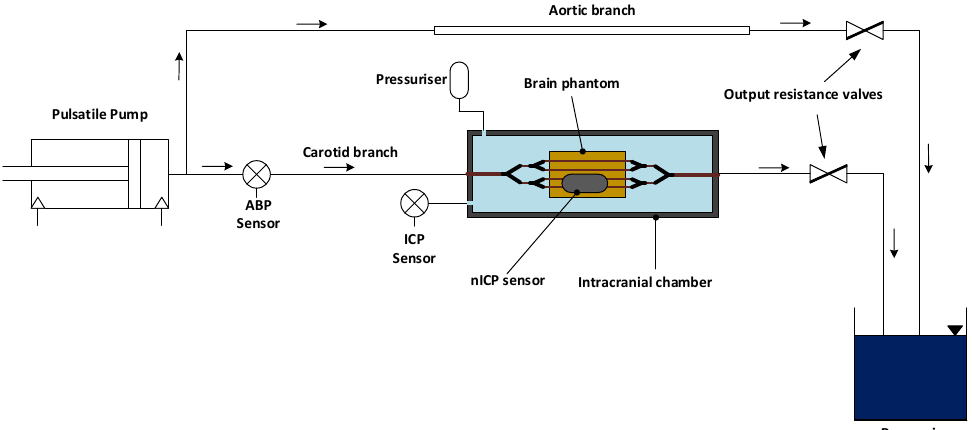
Figure 1. Schematic diagram of the in vitro model. A pulsatile pump on the far left recreates the pumping action of the heart and directs the blood flow into the rest of the system. The cardiovascular system comprises an aortic branch and a carotid branch leading to the intracranial chamber. The latter is composed by a rigid body in which the vascularised brain phantom is enclosed. The intracranial chamber also includes an intracranial pressure (ICP) sensor and a pressuriser, which allows for the control of the intracranial pressure inside the chamber. Blood flow circulates through the simile- arteries in the brain phantom and reaches a reservoir, where the blood is collected and returns to the pulsatile pump. At the output of the carotid and aortic branch, resistance valves are used to regulate the cardiovascular system’s